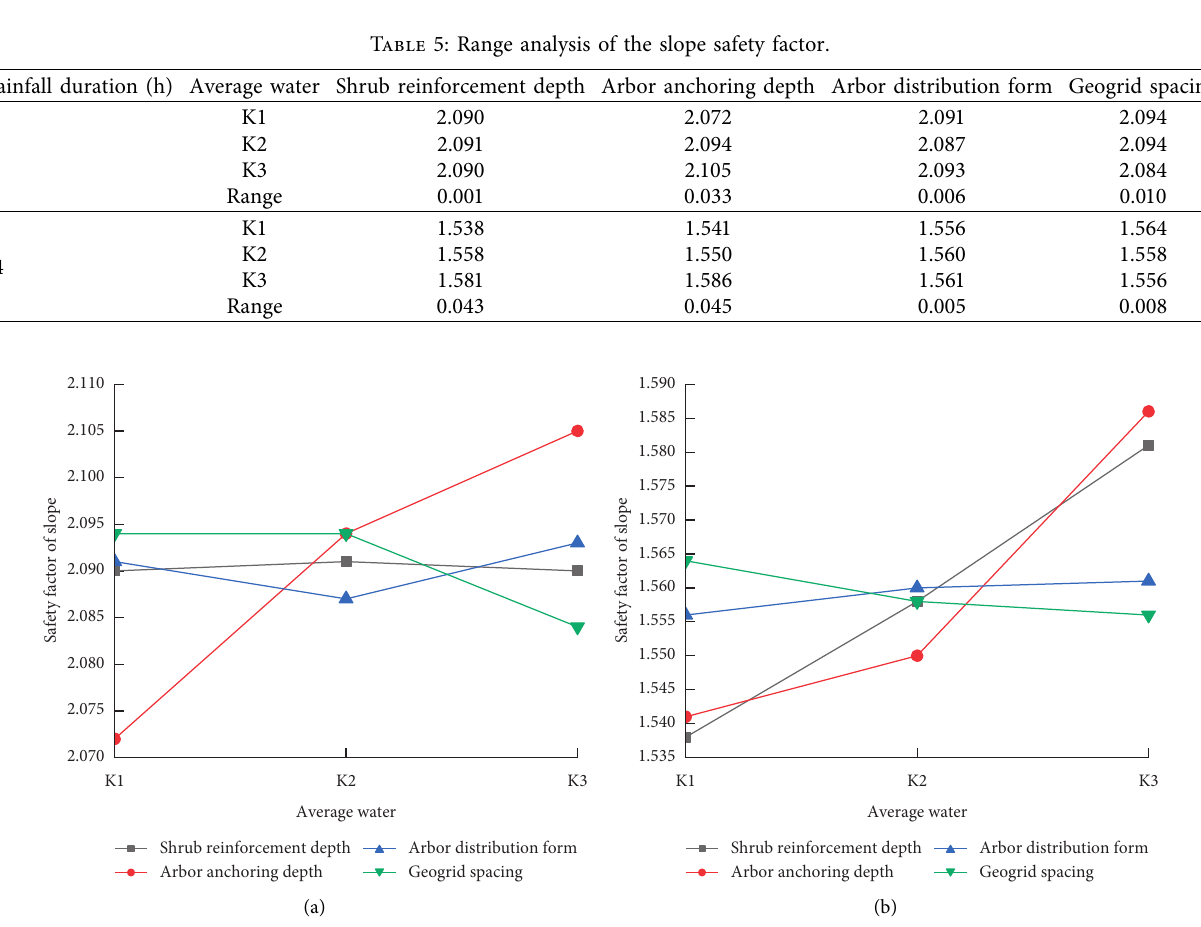
Figure 8: Curves of slope safety factor varying with the average level of various factors under different working conditions. (a) Rainfall 0h. (b) Rainfall